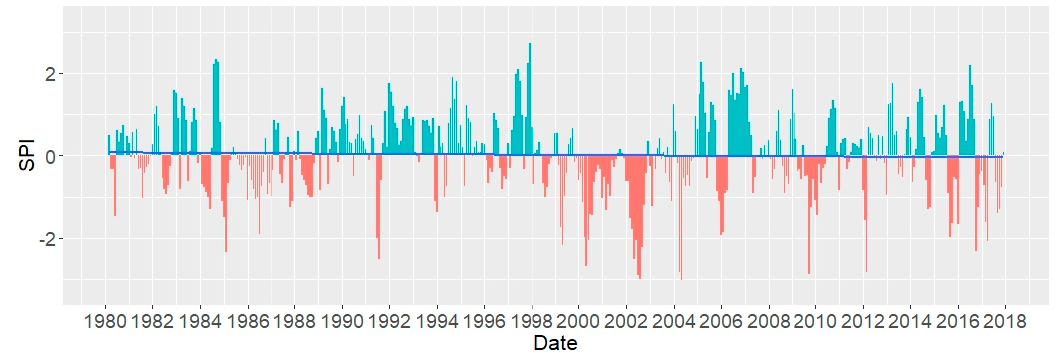
Figure 3. Three-month SPI of the Dalbandin station.